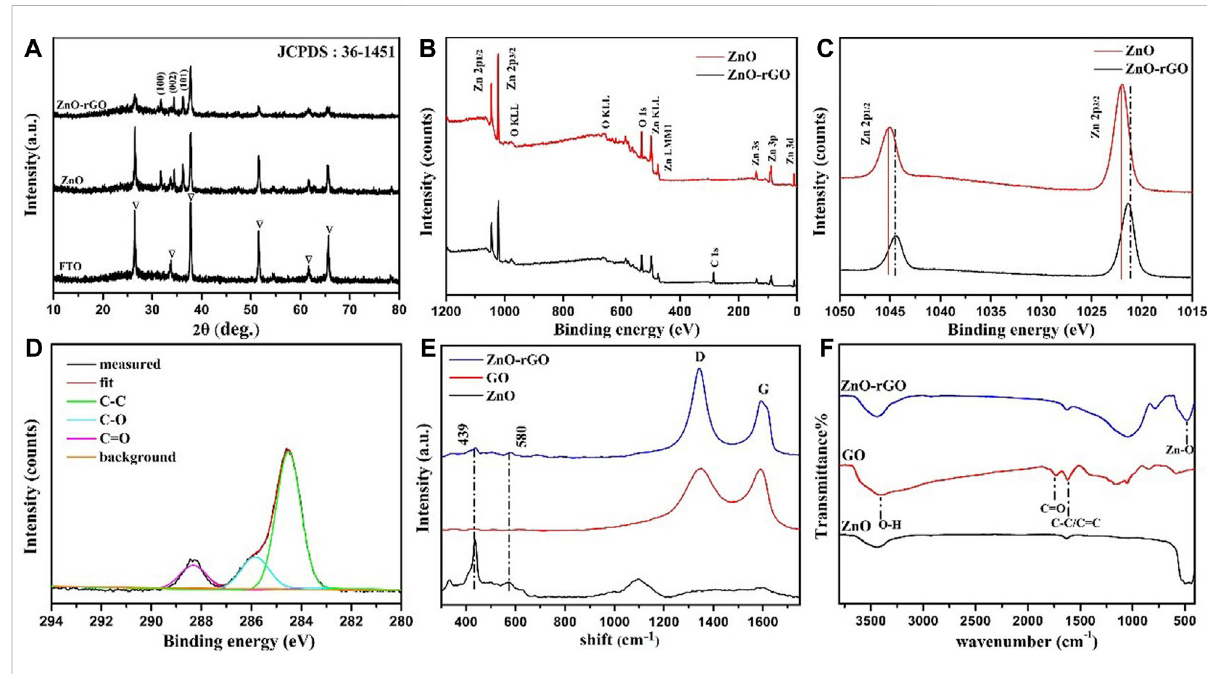
FIGURE 3 XRD patterns of ZnO and ZnO-rGO (A) ; XPS survey spectra of ZnO and ZnO-rGO photoanodes (B) , Zn2p high-resolution spectra of ZnO and ZnO-rGO (C) ,C1sscanspectrumofZnO-rGOphotoanode (D) ;RamanspectraofZnO-rGOandGOcompositematerials (E) andFTIRspectraofGO, ZnO and ZnO-rGO composites (F) .